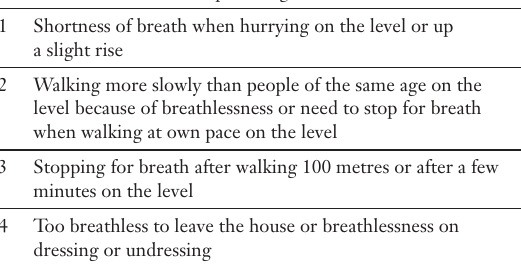
Modified Medical Re- search Council Scale